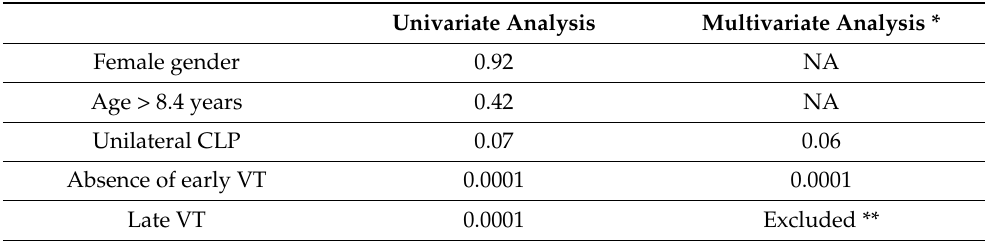
Table 2. Univariate and multivariate analyses of the outcome (presence of hearing loss at last follow-up) of cleft lip and palate